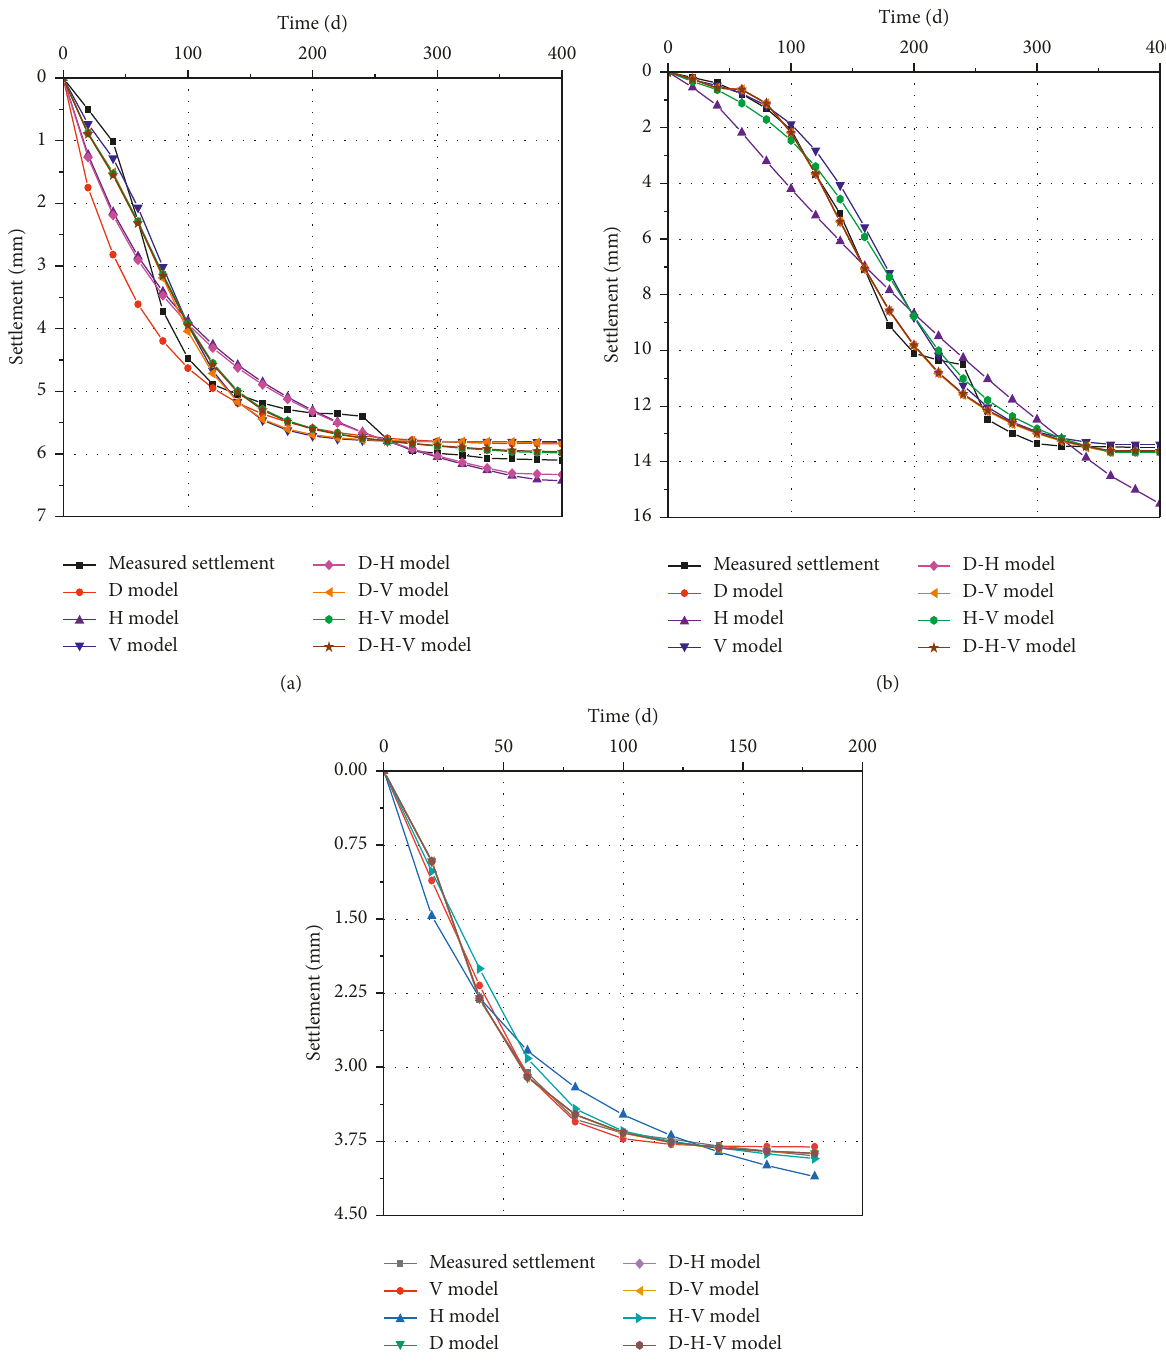
Figure 2: Curves of measured settlement and predicted settlement. (a) DK84 +771 section. (b) DK84 +821 section. (c) DK123 +960